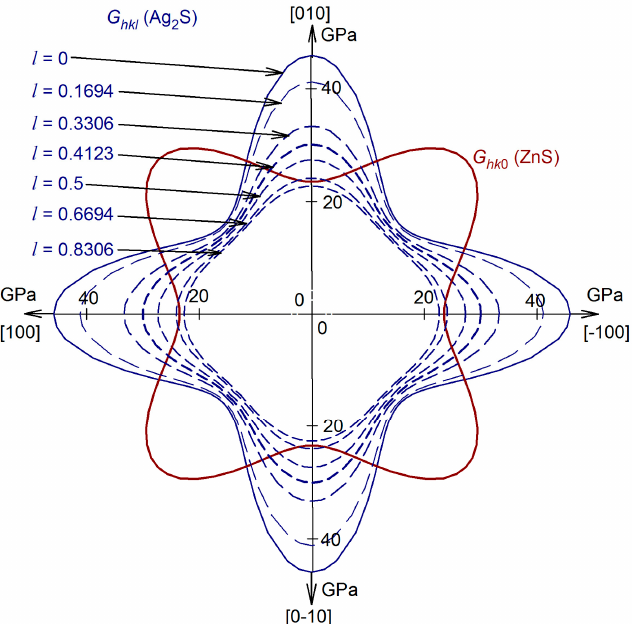
Figure 23. Comparison of the shear moduli G hkl of cubic β -Ag 2 S argentite in the (hkl) planes with l = 0, 0.1694, 0.3306, 0.4123, 0.5, 0.6694, and 0.8305 with the shear modulus G hk0 of cubic ZnS sphalerite in the (hk0) plane. Reprinted with permission from Ref. [84]. 2022, Elsevier.